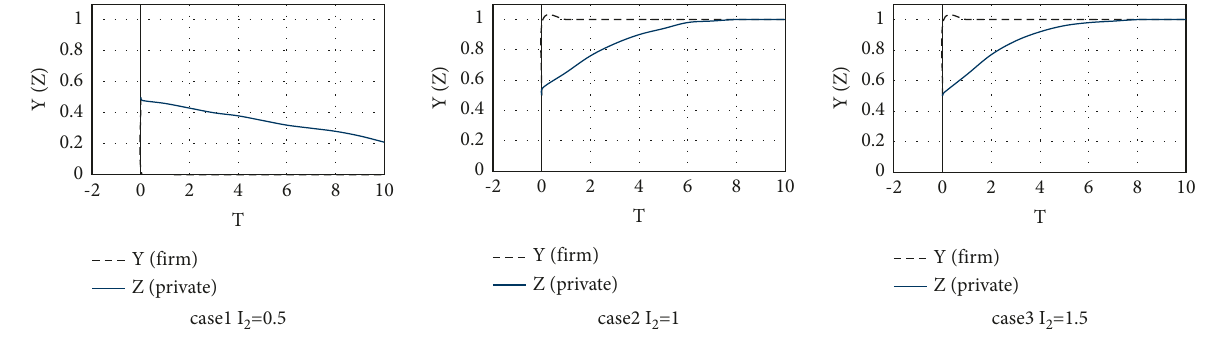
Figure 2: I 2 impact of changes on the evolution of co-created